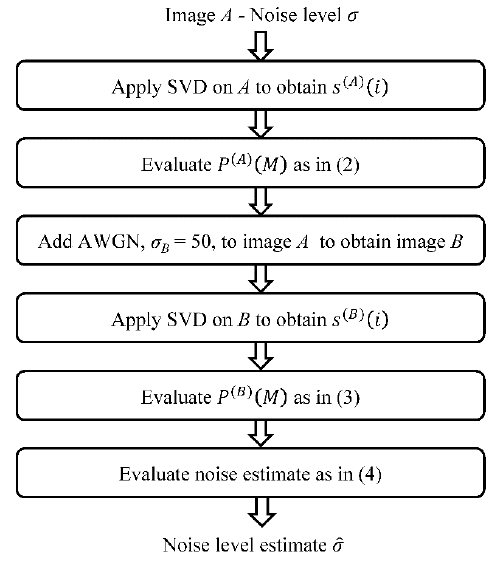
Figure 2. Noise level estimation in the SVD domain.